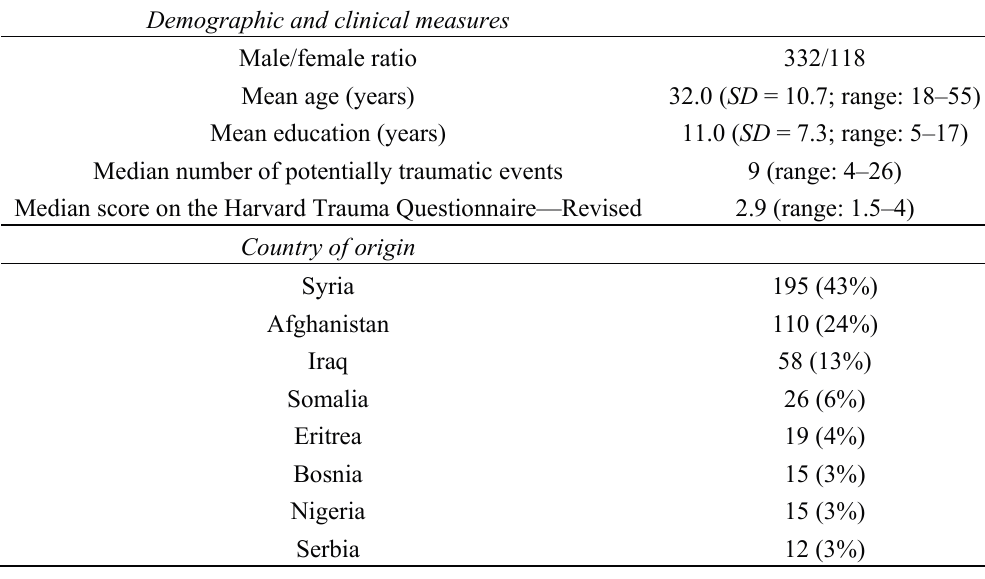
Table 1. Socio-demographic characteristics of the participants.